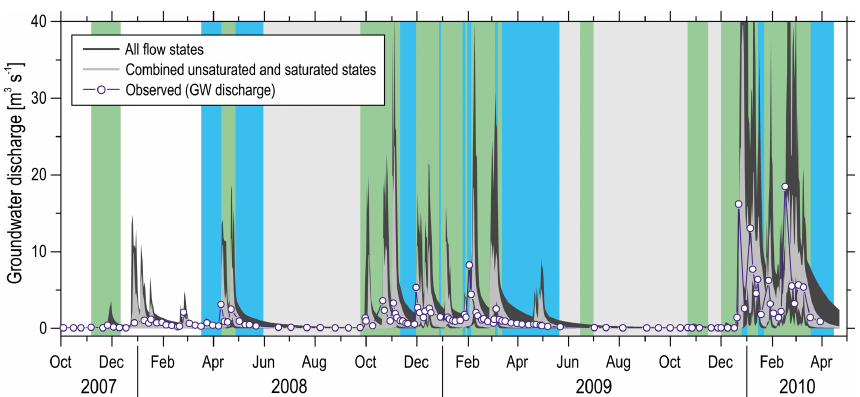
Figure 7. Observed discharge and the simulation uncertainty of the final parameter sample (all KGE ≥ 0 . 2) of the combined unsaturated and saturated flow states and the all flow states including the disinformative period of river influence. Background colours representing flow states match those in Fig.